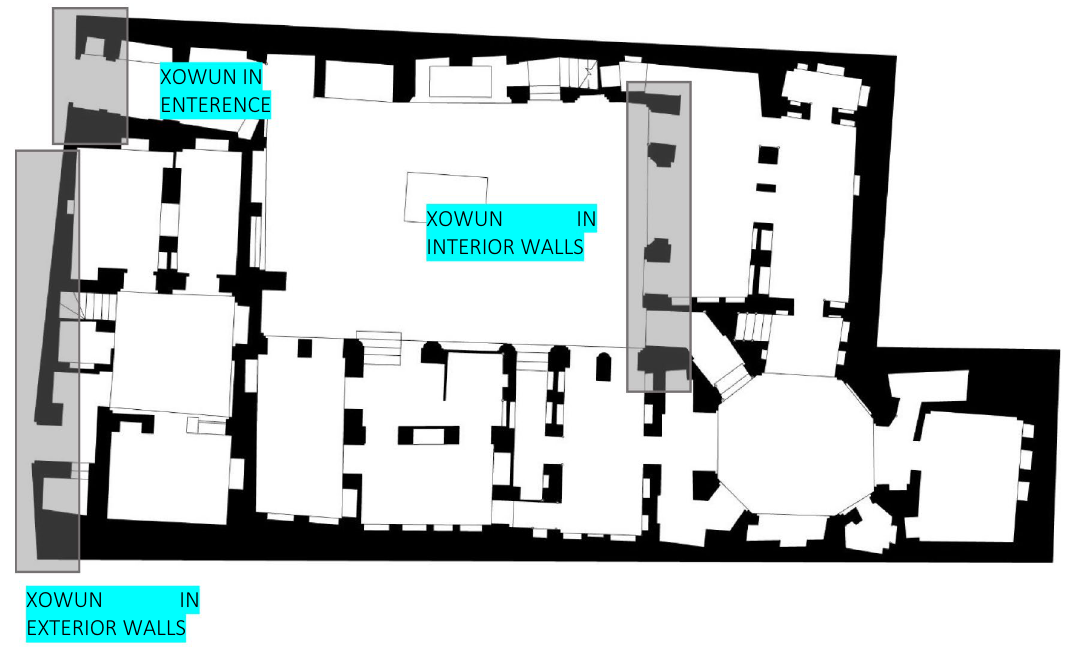
Fig. 2 The plan of Ghalambor house in